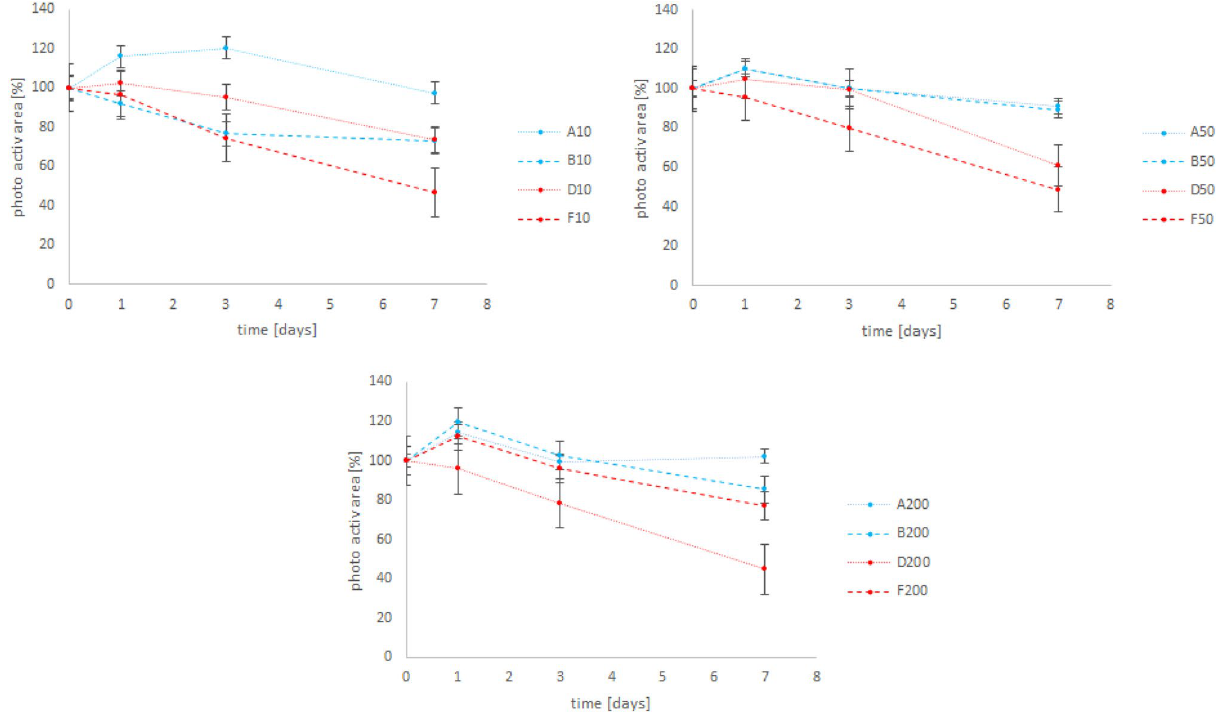
Figure 4. Mean photosynthetic area of the tested foraminifera (six replicates, error bars indicate standard error). A and B are the conventional and D and F the “eco-friendly” sunscreens (see Table 1 for more detail). The values are in percent to the control (control values are